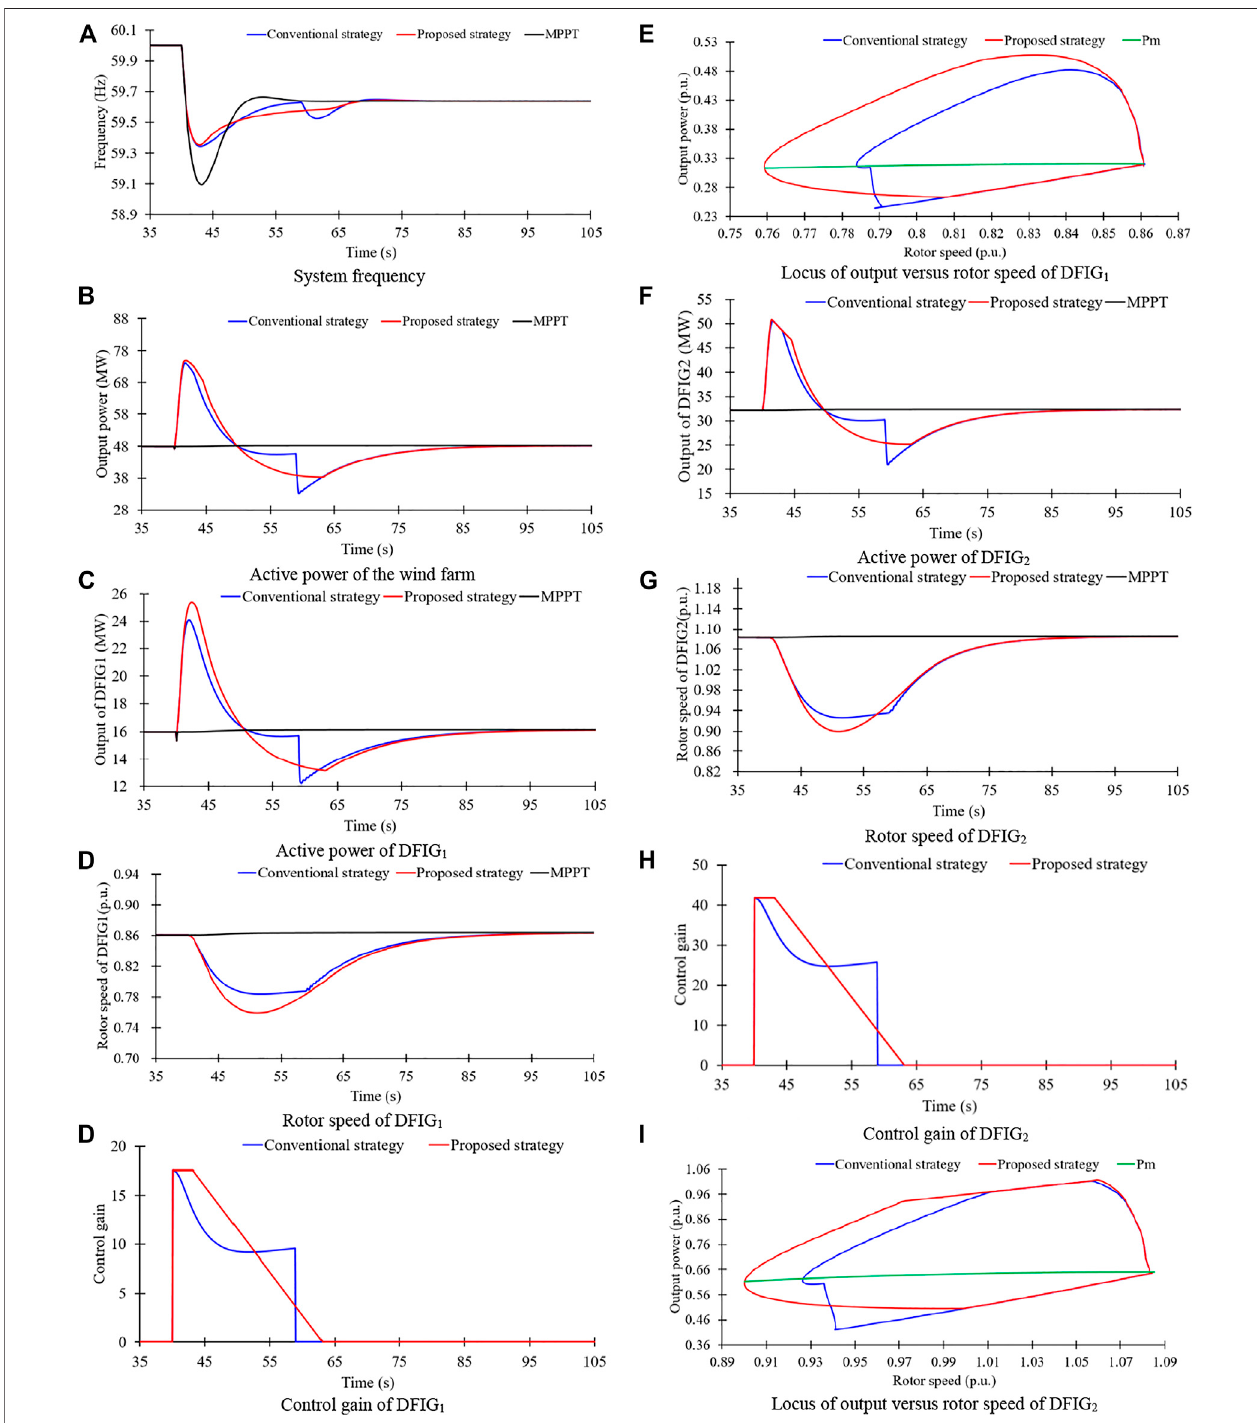
FIGURE 10 | Results for case 1. (A) System frequency. (B) Active power of the wind farm. (C) Active power of DFIG 1 . (D) Rotor speed of DFIG 1 , Control gain of DFIG 1 . (E) Locus of output versusrotor speed of DFIG 1 . (F) Active power of DFIG 2 . (G) Rotor speed of DFIG 2 . (H) Control gain of DFIG 2 . (I) Locus of output versus rotor speed of DFIG 2